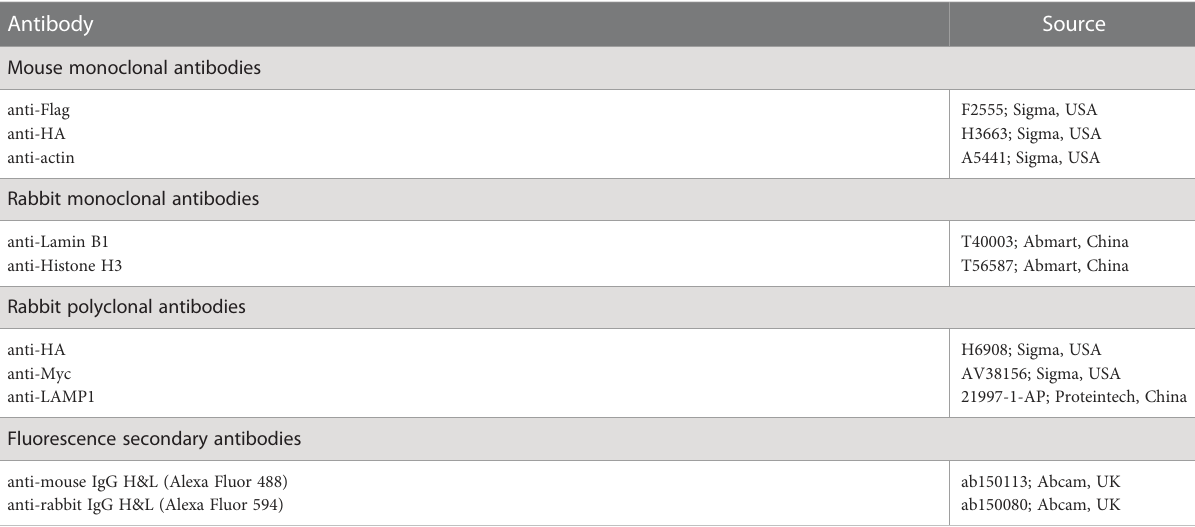
TABLE 2 Antibodies used in this study.